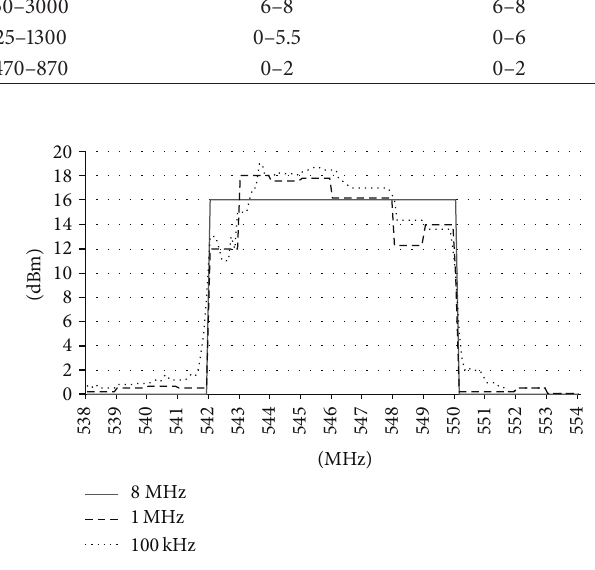
Figure 2: Comparison between the scaled signal power values (dBm) for 8 MHz and 1MHz